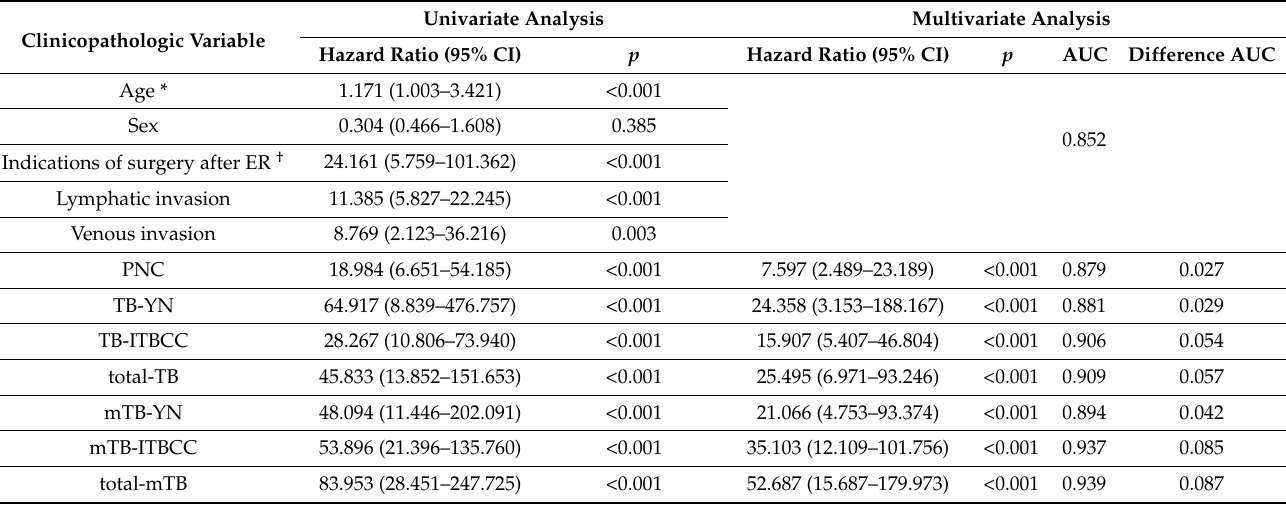
Table 3. Association of morphologically signet ring cell-equivalent tumor budding and lymph node metastasis in early gastric cancer with signet ring cell component and undifferentiated-type